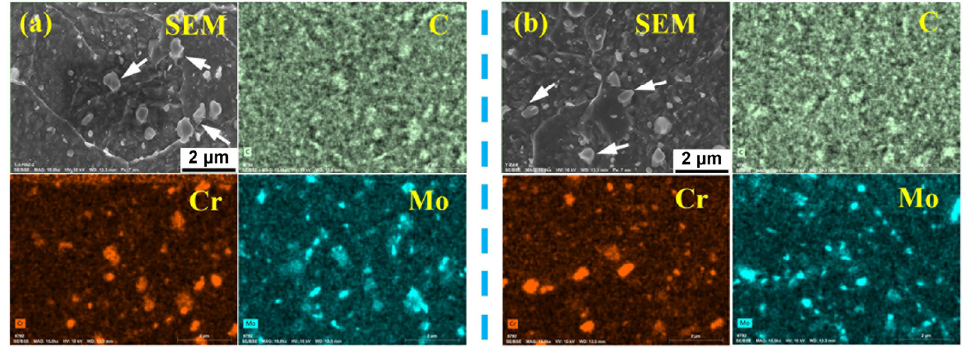
Figure 7. Carbides in the FGHAZs: ( a ) the turbine part; ( b ) the compressor part. The white arrows point to carbides.